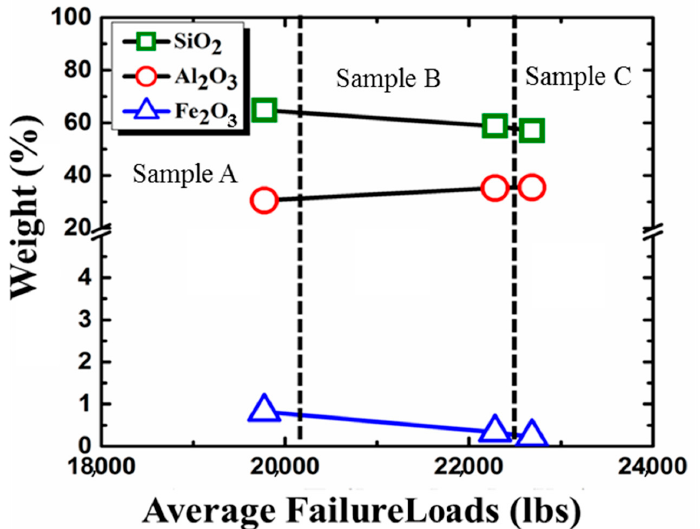
Figure 7. Load at which failure occurred for samples A, B, and C based on the weight percentage of porcelain constituents and load tests.